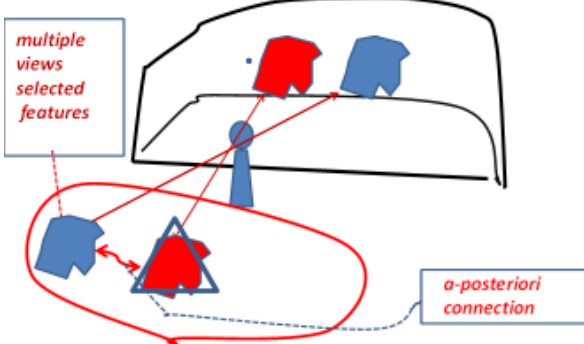
Figure 3. The scientific program is a linguistic task. Galileo’s approach consists of extracting mathematical features; it implies a linguistic operation, according to Fig.2.